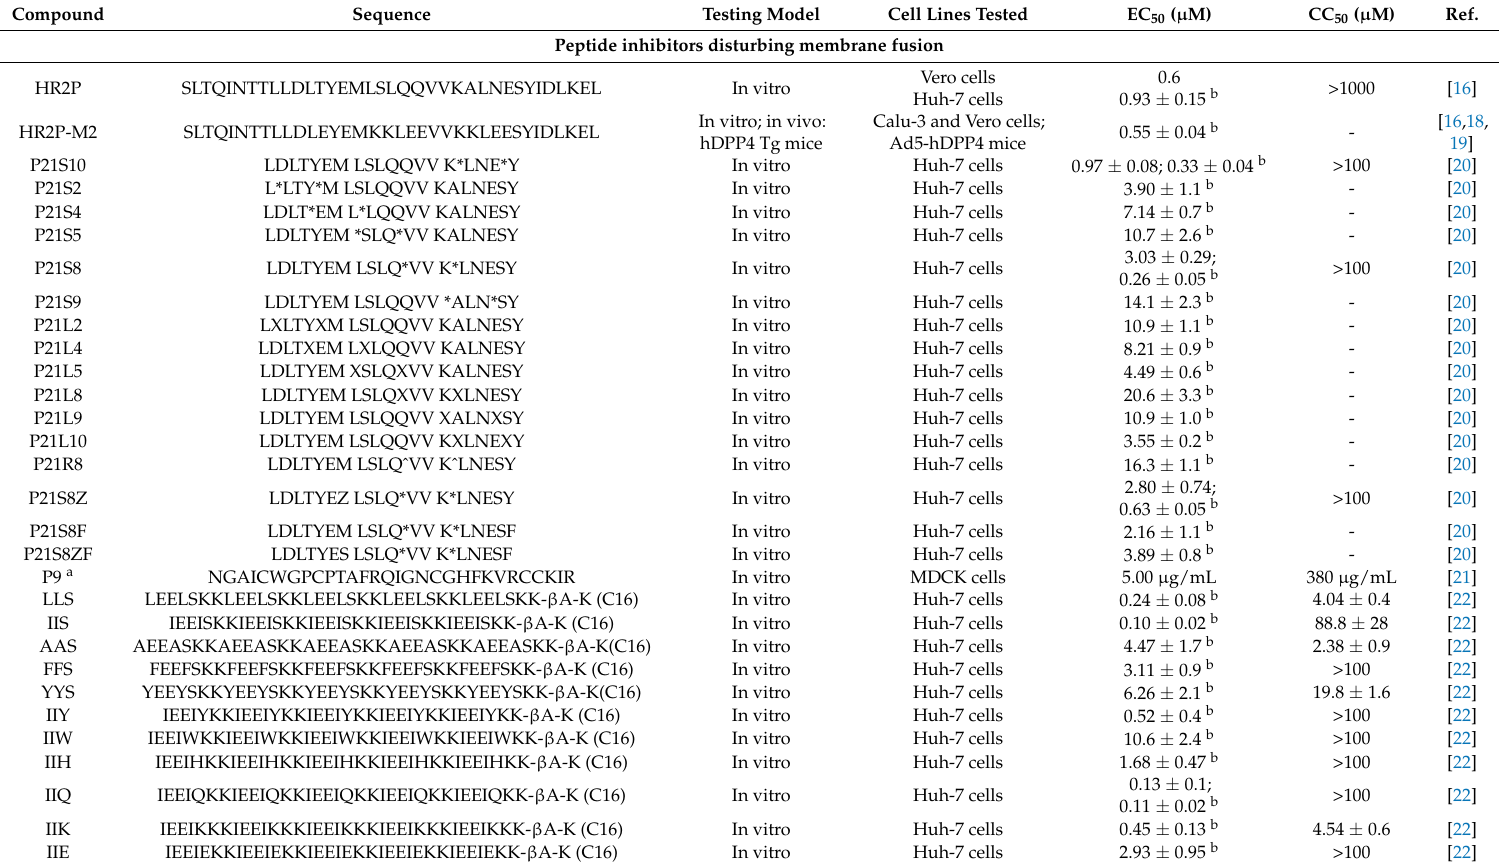
a P9-aci-1: three acidic amino acids D, E, and D were added to the C-terminus of P9. b Concentration of peptide that blocks MERS-CoV S-mediated cell–cell fusion. “-” indicates data not available. “*” indicates the position of the S5 residues, which react to form the all hydrocarbon staple. “ˆ” indicates the positions of the R5 amino acids, which react to form staples. EC 50 : concentration for 50% of maximal effect. CC 50 : the 50% cytotoxicity